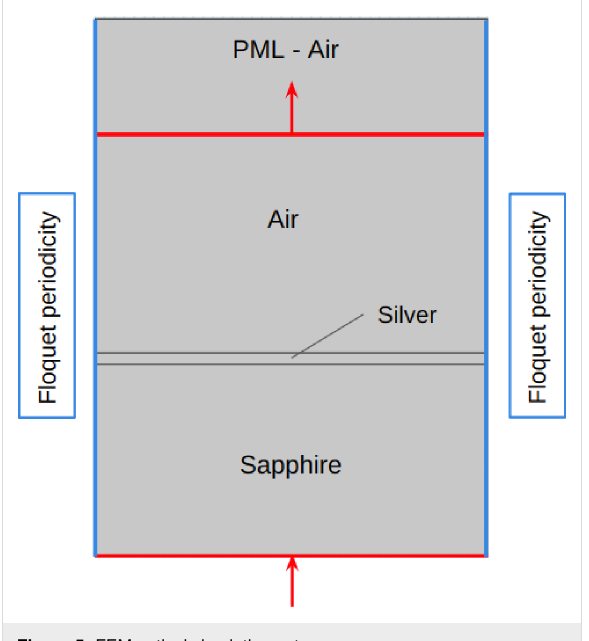
Figure 5: FEM optical simulation